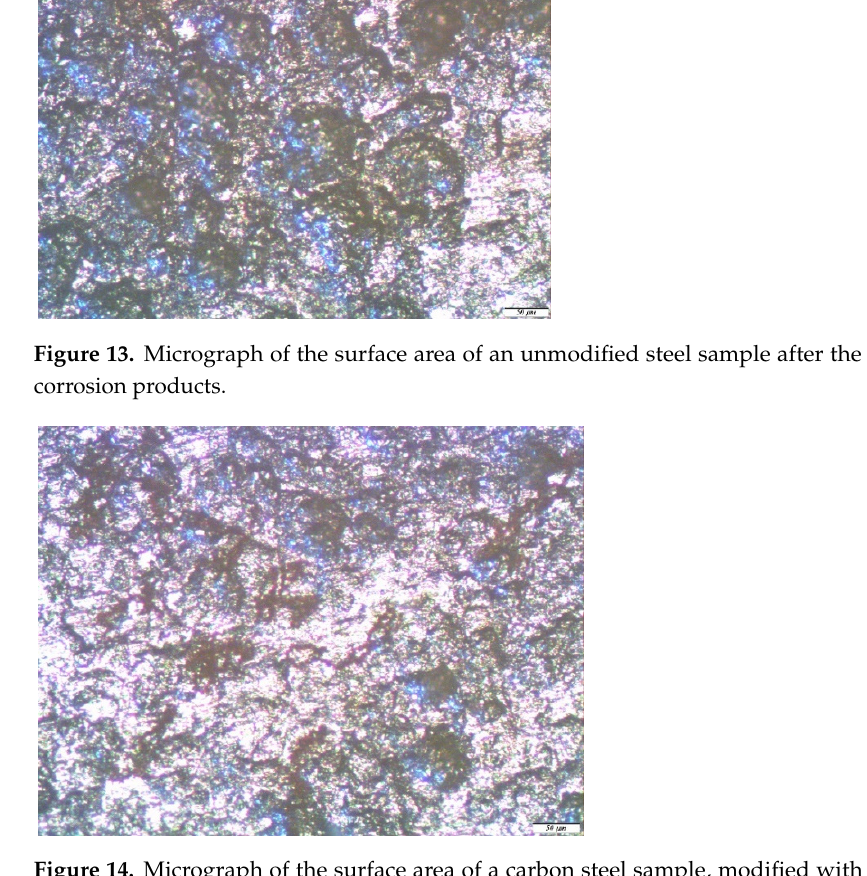
Figure 14. Micrograph of the surface area of a carbon steel sample, modified with a 1% VS water solution or 3% VS water solution, after conducting full-scale, one-year natural corrosion tests in an urban atmosphere and removing the corrosion products.